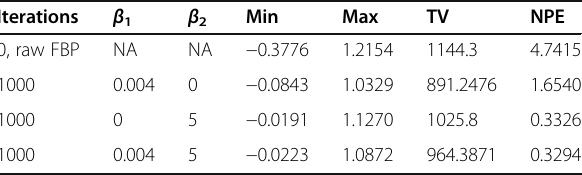
Table 6 Values of maximum, minimum, metal-free region TV, and NPE in reconstructions of bag #5 (New threshold value to segment the metal image and new β 1 =